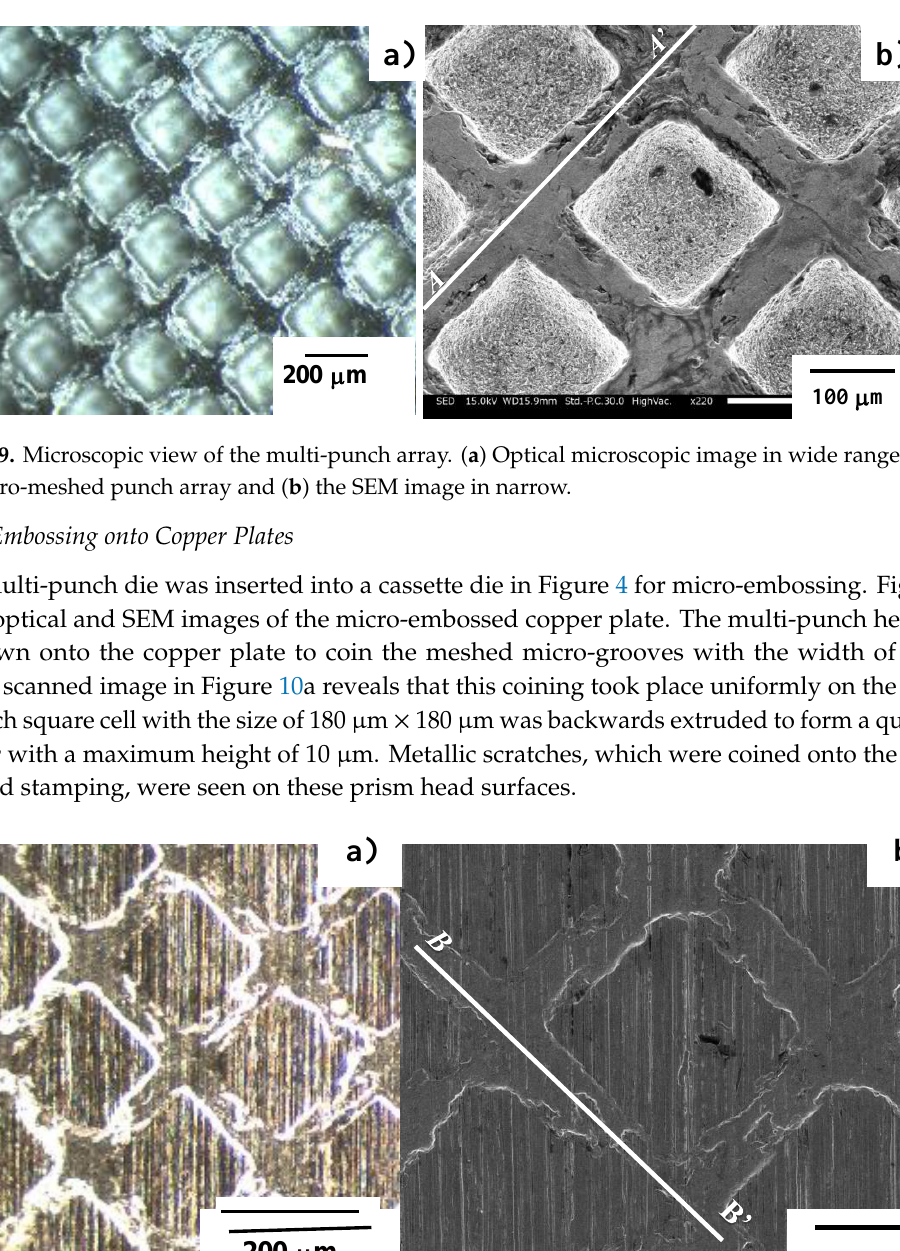
Figure 10. Micro-embossed copper plate by incremental loading every 20 μ m until the maximum load reached 30 kN. ( a ) Optical microscopic image in wide range and ( b ) the SEM image in narrow range.